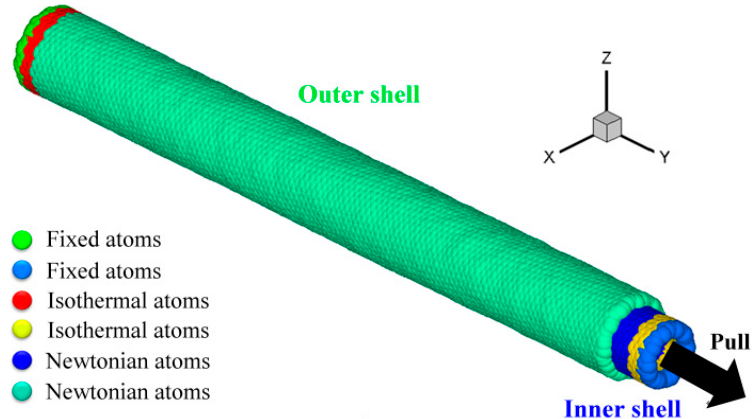
Figure 1. Molecular dynamics (MD) model of double-walled carbon nanotubes (DWCNTs). The model consists of an inner shell and an outer shell, whose lengths are both 30 nm. The diameters of the outer and inner shells are 2.73 and 2.4 nm, respectively.